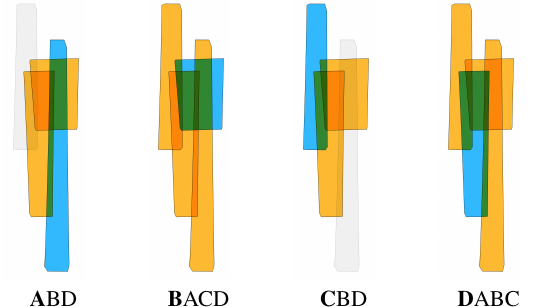
Figure 6: Multi-strip sub-blocks for the block shown in Figure 4; blue: primary strip; orange: secondary strips